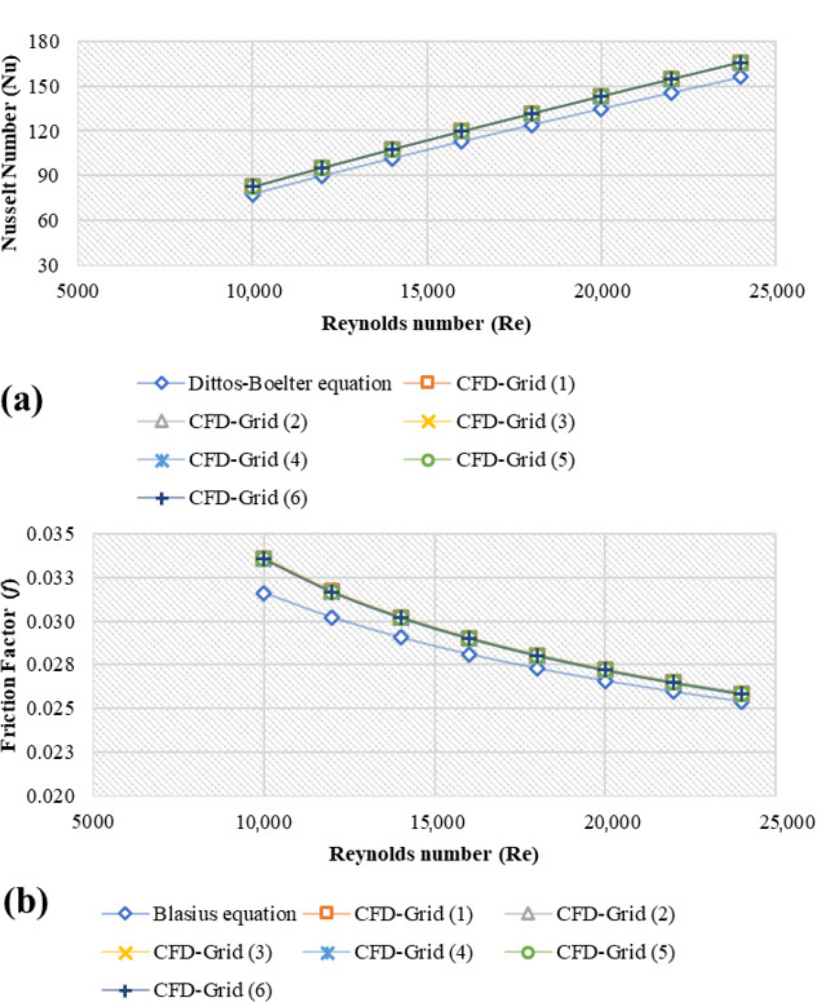
Figure 2. Grid Independence Test against different Reynolds numbers and different CFD grid sizes at 293 K; ( a ) Average Nusselt number, ( b ) friction